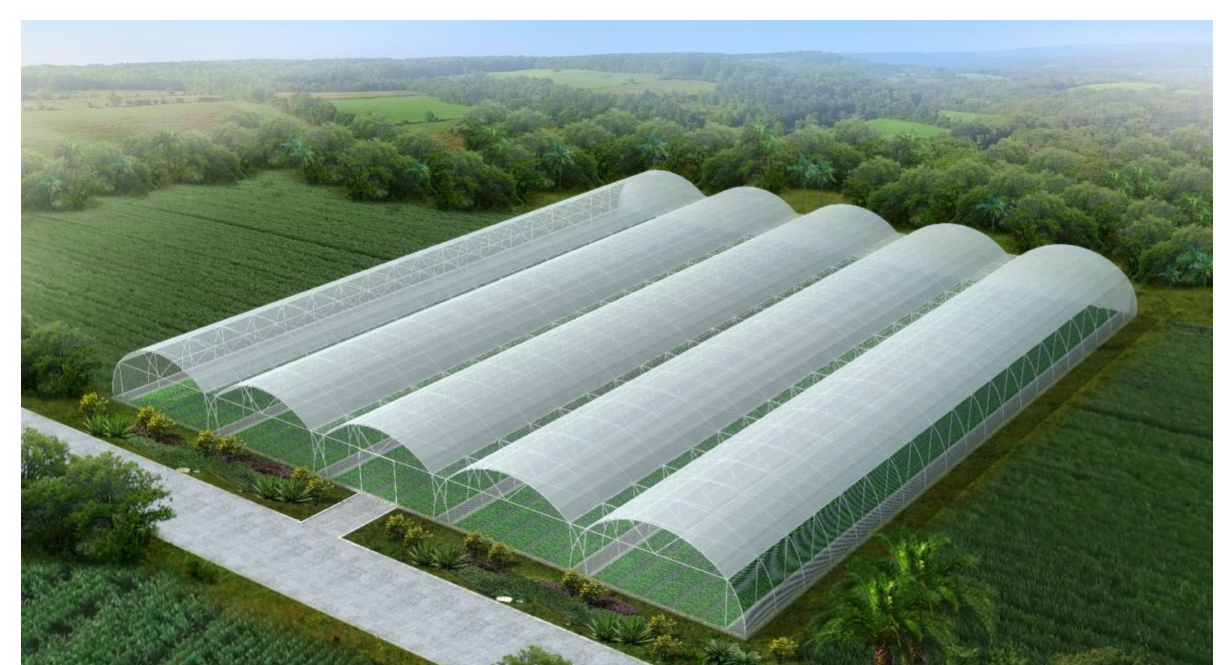
Figure 6. Design sketch of a multi-arch greenhouse.